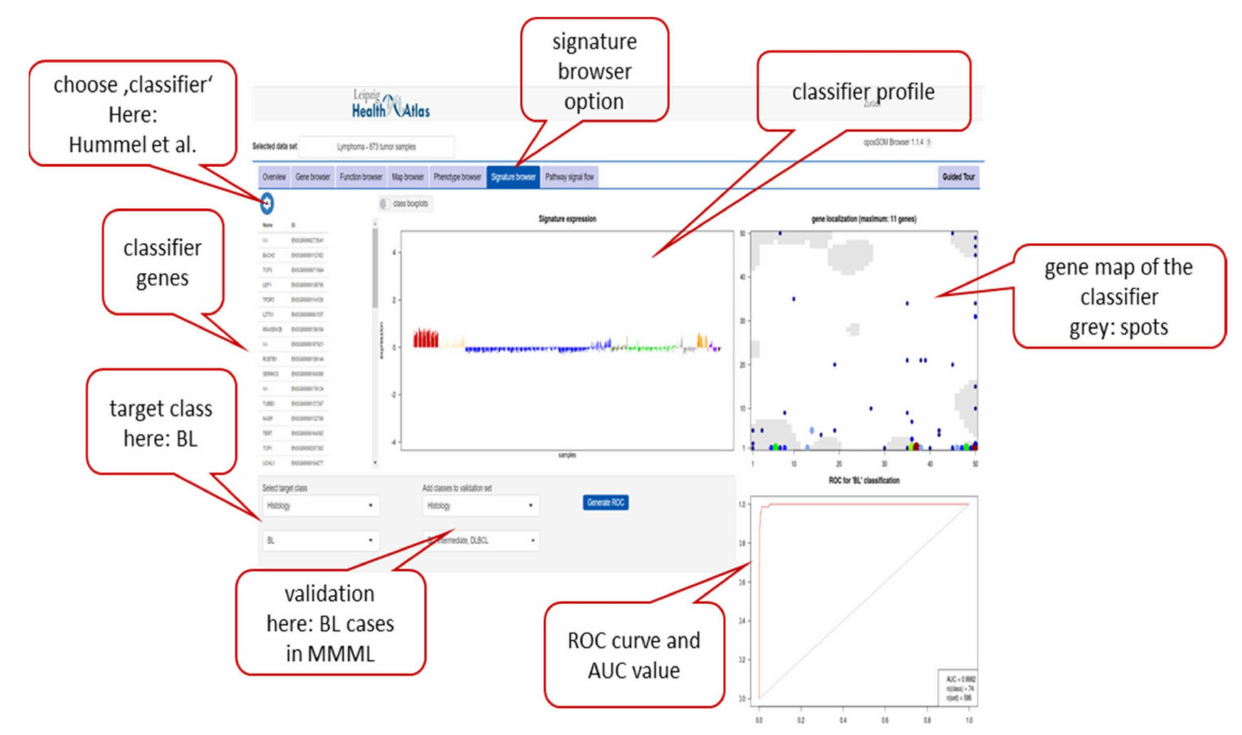
Figure A1. Screenshot of the signature browser implemented in the opoSOM